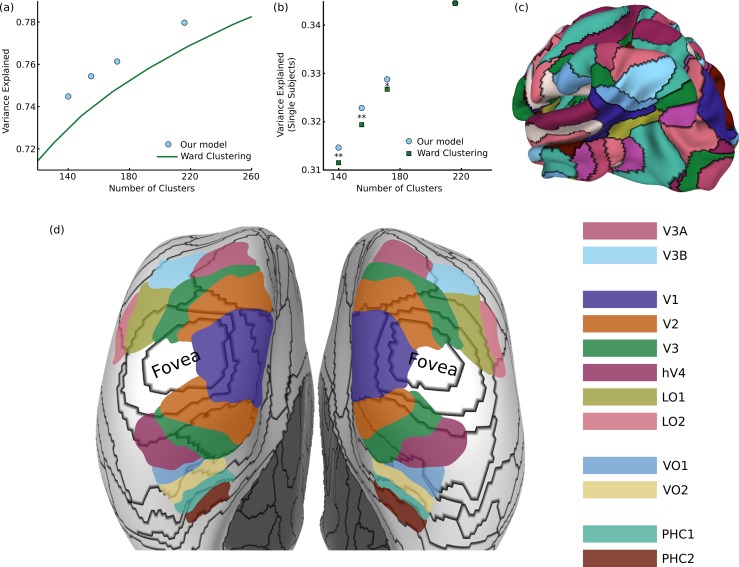
Results on functional brain connectivity(A) Our model consistently provides a better fit to the data than greedy clustering, explaining the same amount of variance with 30 fewer clusters (different points were generated from different values of the hyperparameter \documentclass[12pt]{minimal}
\usepackage{amsmath}
\usepackage{wasysym} 
\usepackage{amsfonts} 
\usepackage{amssymb} 
\usepackage{amsbsy}
\usepackage{upgreek}
\usepackage{mathrsfs}
\setlength{\oddsidemargin}{-69pt}
\begin{document}
}{}${\sigma }_{0}^{2}$\end{document}σ02). (B) When using our group-learned clustering to explain variance in 20 individual subjects, we consistently generalize better than the greedy clusters for cluster sizes less than 200 (∗
p < 0.05, ∗∗
p < 0.01). (C) A sample 172-cluster parcellation from our method. (D) Comparison between our parcels and retinotopic maps, showing a transition from eccentricity-based divisions to field map divisions.